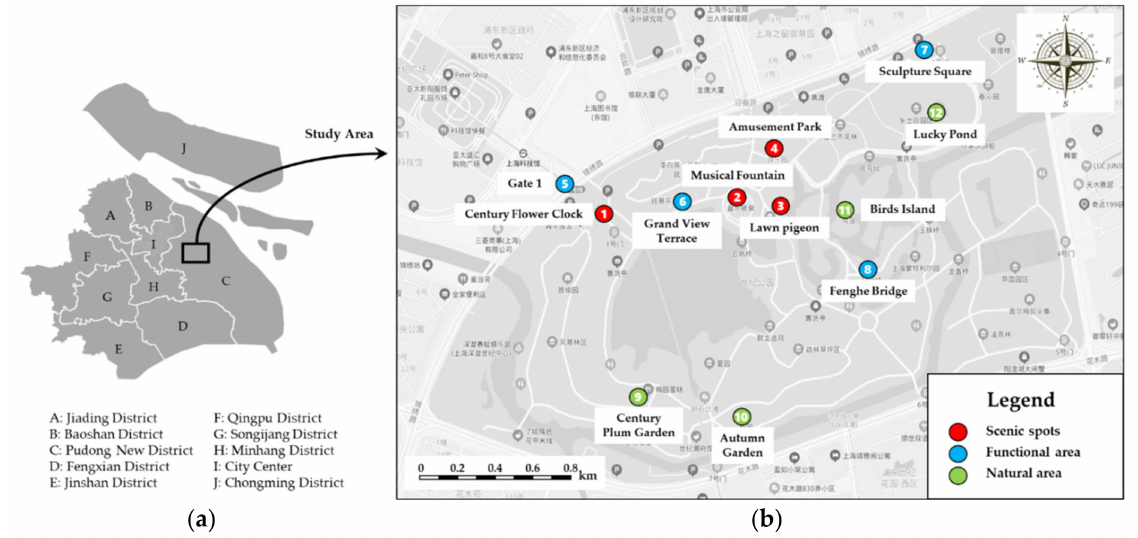
Figure 1. Map showing ( a ) the location of Century Park in the zoning map of Shanghai and ( b ) the locations of 12 sampled areas of Shanghai Century Park. The figure was created by the